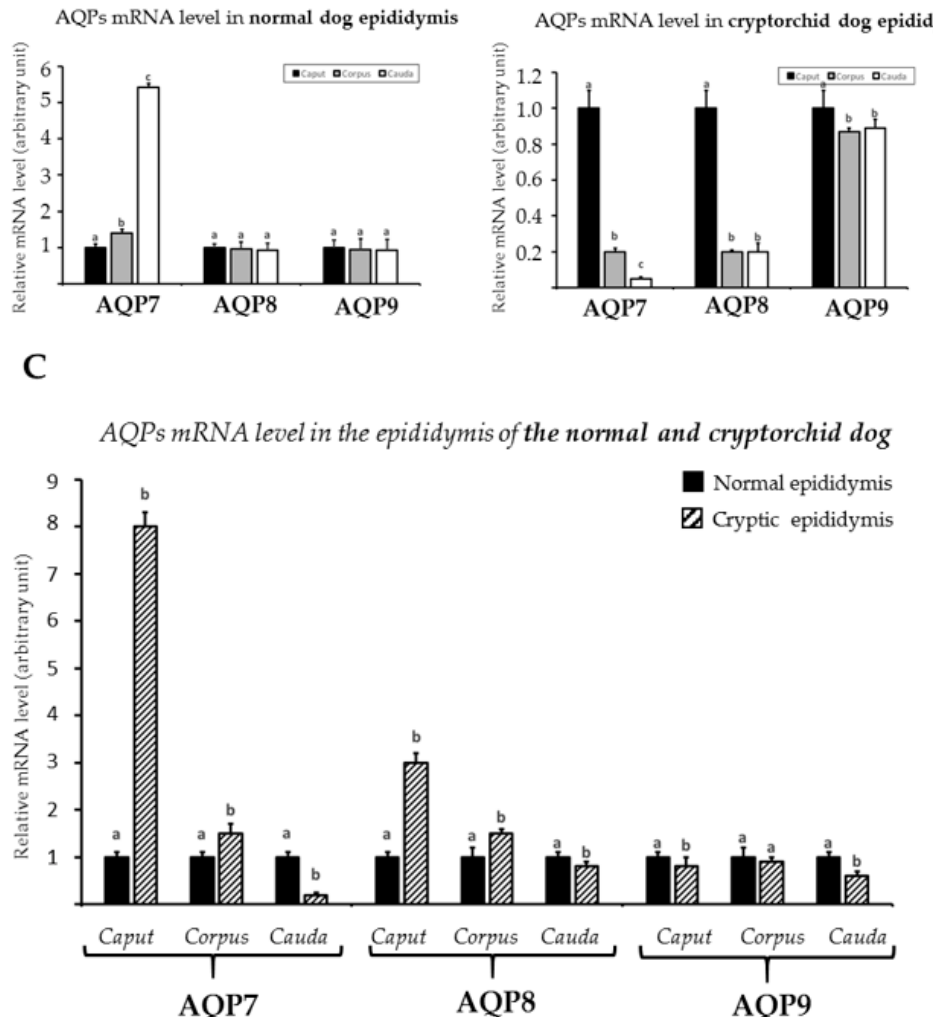
Figure 5. AQP7, AQP8, and AQP9 mRNA level expression in the normal ( A , C ) and cryptorchid dogs ( B , C ). ( A ) The calibrator is the normal epididymis caput. ( B ) The calibrator is the cryptic epididymis caput. ( C ) The calibrator is the normal epididymal segment. Each plotted value corresponds to the mean ± standard deviation (SD) obtained from three independent experiments. Different letters depict differences between the examined groups ( p < 0.05).